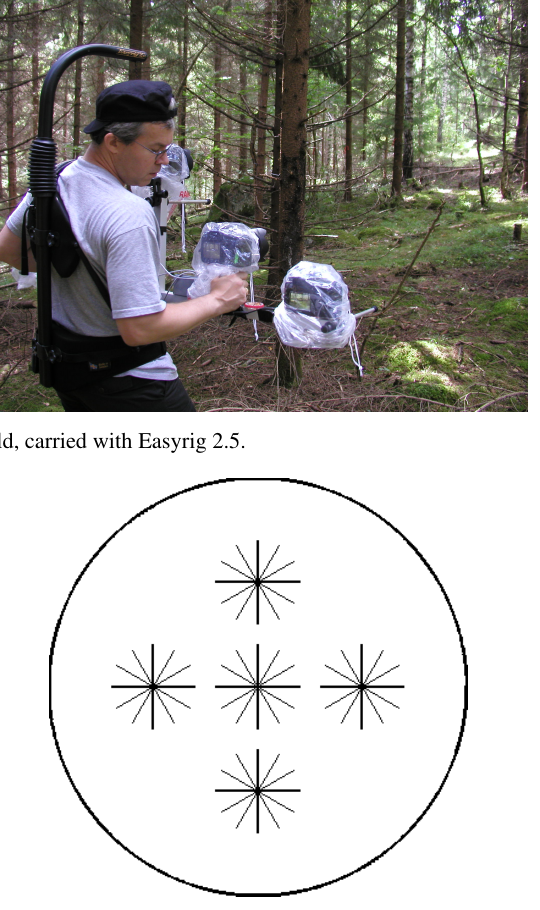
Figure 2: The PhotoModeler camera calibration sheet printed on a sheet of aluminium. Stringers were attached to the back of the sheet for additional stability.